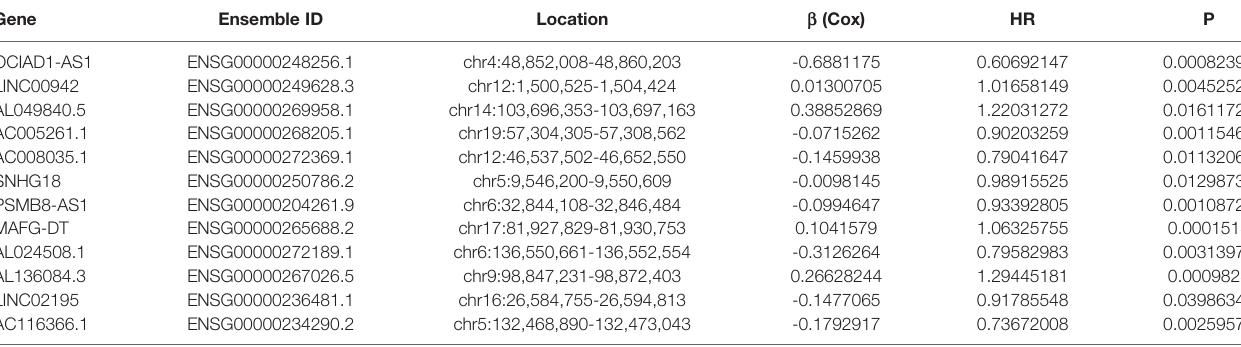
TABLE 1 | The detailed information of lncRNAs for constructing the pyroptosis-related prognostic signature. Gene Ensemble ID Location b (Cox) HR